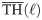
Reduction operation of type H.Depiction of the reduction operation H(N, ℓ). The nodes inside the dotted box form TH¯(ℓ) and will be removed, which will create elementary nodes that will be substituted by arcs.